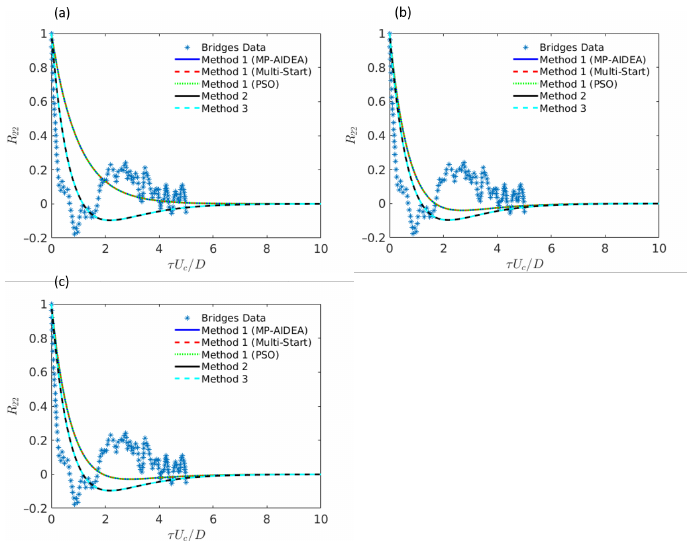
Figure 9. Comparison of R 22 for different optimization methods and routines ( a ) Ma = 0.5 ( b ) Ma = 0.7 ( c ) Ma = 0.9.